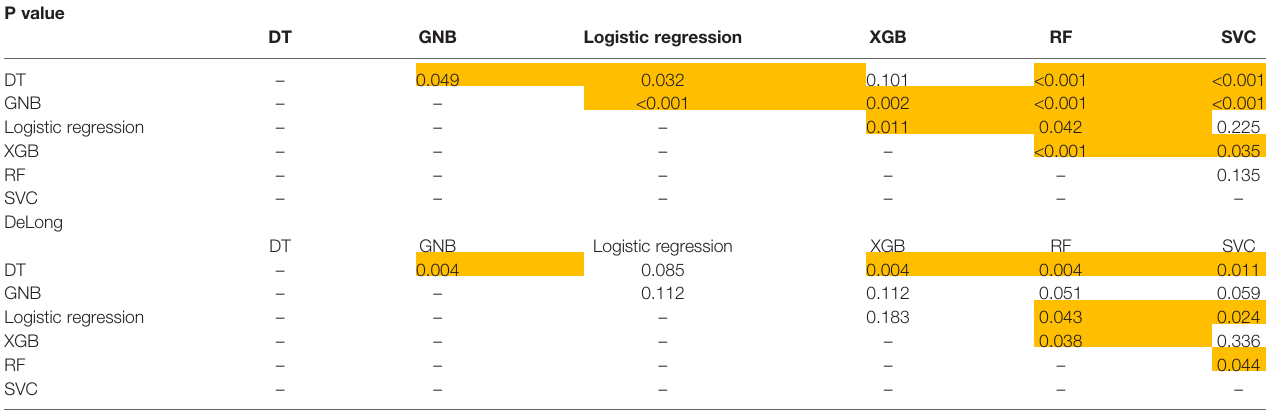
TABLE 6 | P value and DeLong test of each classi fi er on the sequence-combined model based on lesions for predicting